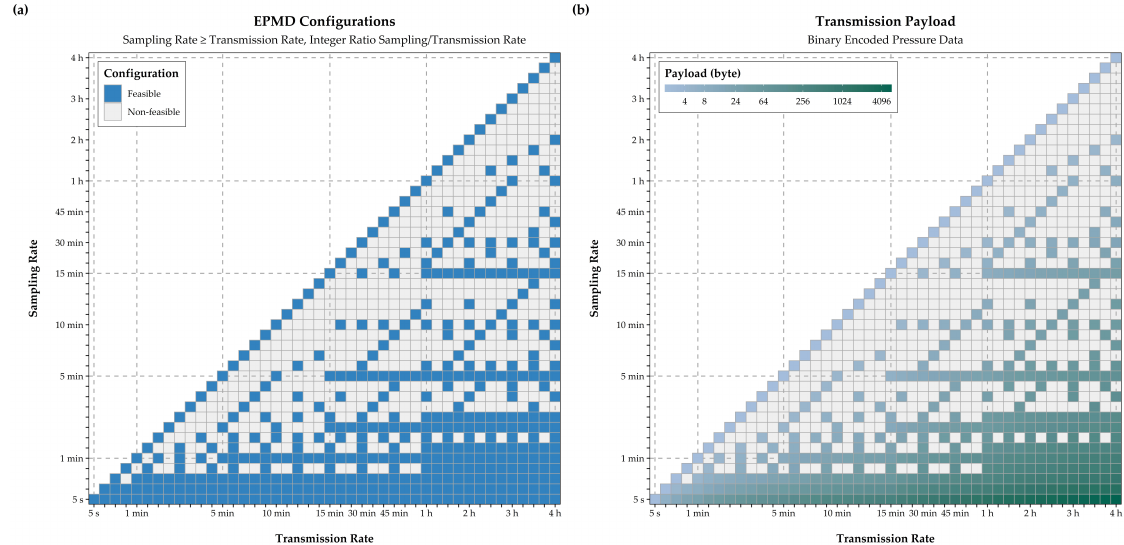
Figure 4. Feasible EPMD configurations ( a ) and payload size for a single transmission ( b